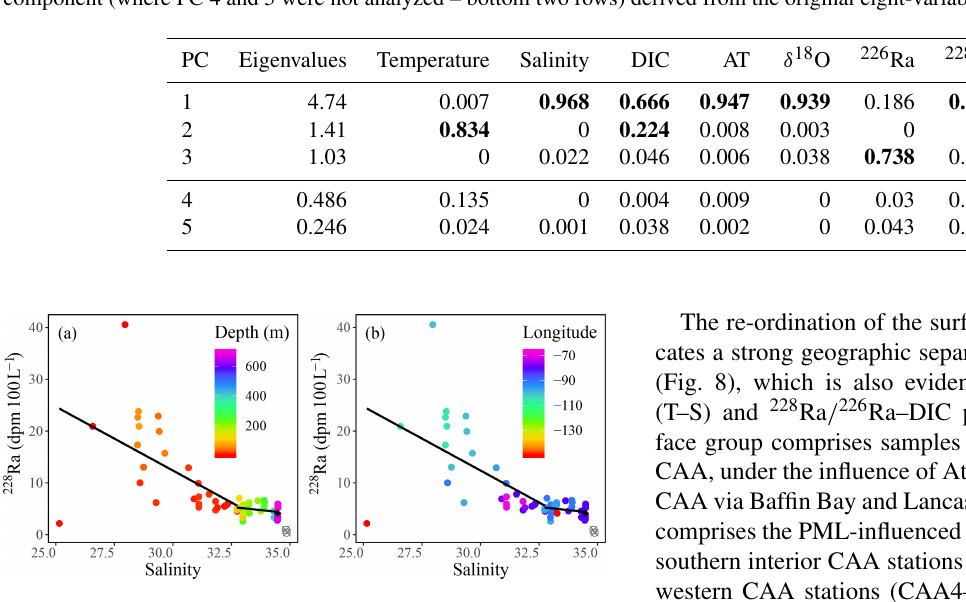
Figure 6. 228 Ra (dpm100L − 1 ) plotted against practical salinity ( S P ), with the color indicating (a) depth and (b) longitude, fit- ted with a piecewise regression excluding the deep stations of the Canada Basin (gray circles) and yielding 228 Ra = ( − 2 . 5 ± 0 . 8 ) × S P + 86 . 4 ± 23 . 6 ( R 2 = 0 . 28) for the surface trend (0–80m) and 228 Ra = ( − 0 . 5 ± 0 . 3 ) × S 2 = 0 . 07) for the deep P + 21 . 1 ± 10 . 5 ( R trend ( > 80m). The average of Atlantic deep waters sampled from stations CAA1, CAA2, and CAA3 is defined using a black